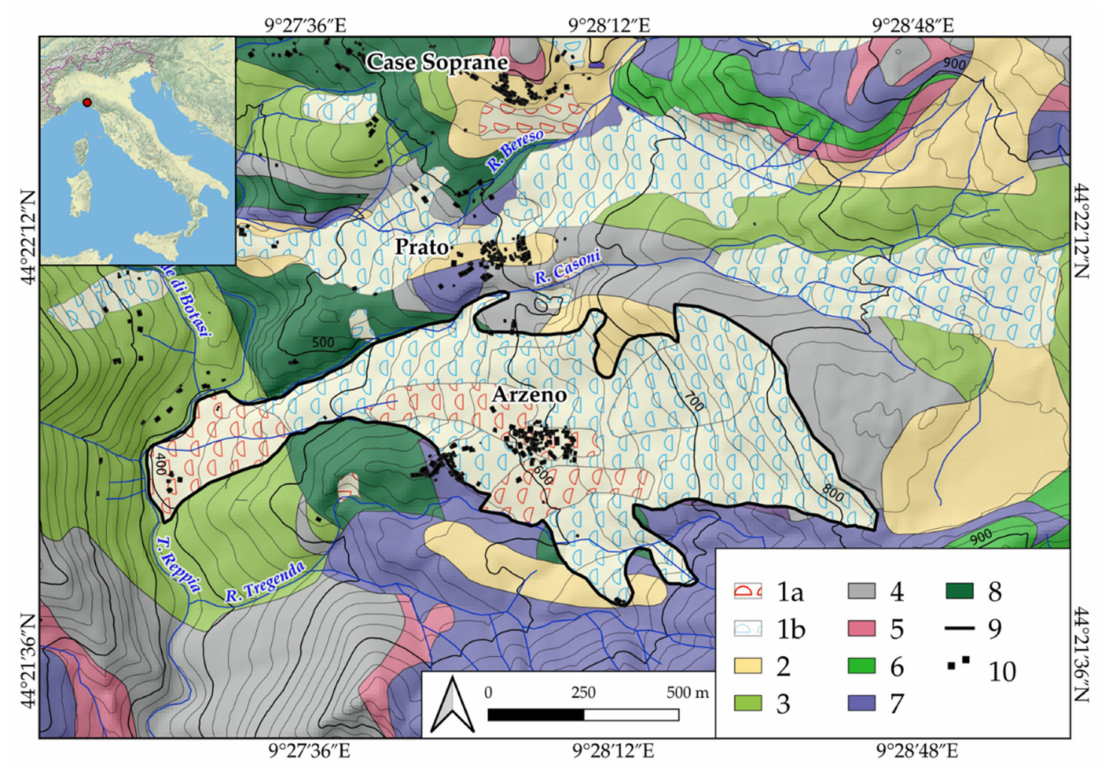
Figure 3. Geological sketch map of the area of the Arzeno landslide (red dot in the upper im- age), modified from [24]: (1a) Active landslide; (1b) Inactive landslide; (2) Other quaternary de- posits: slope, alluvial, lacustrine; (3) Shales with limestones; (4) Limestones; (5) Cherts; (6) Basalts; (7) Ophicalcites and ophiolitic breccias; (8) Serpentinites; (9) Perimeter of the Arzeno landslide; (10) Buildings. Landslide activity according to IFFI